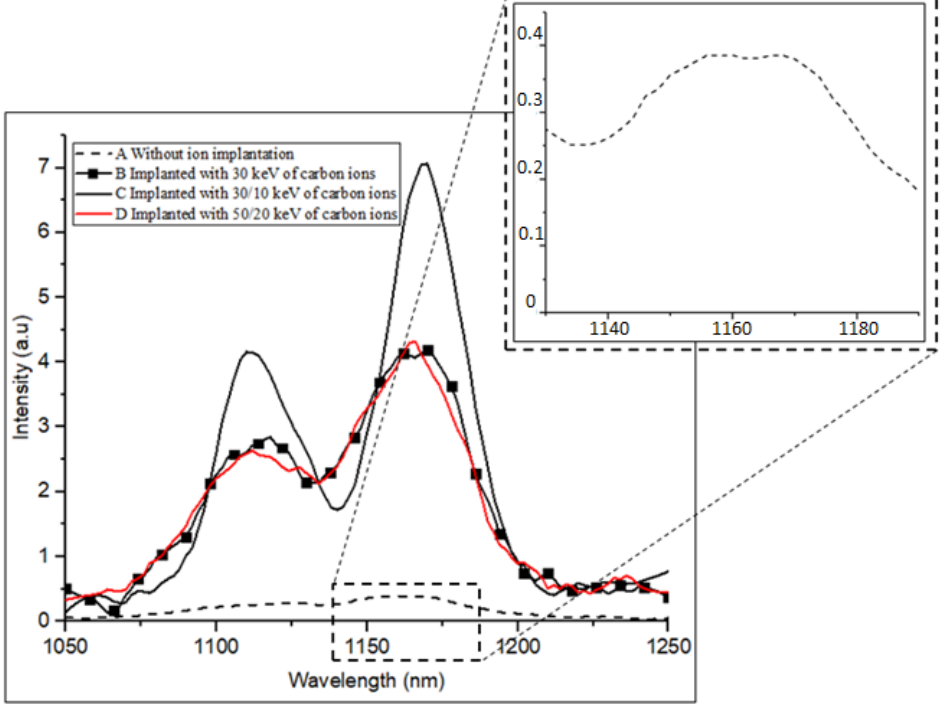
Figure 3. PL spectrum of samples A, B, C and D at 80 K. Sample A is the reference sample without ion implantation. Sample B is implanted with 30 keV of carbon ions, whereas samples C and D have double implantation of 30/10 and 50/20 keV of carbon ions, respectively. FWHM for the highest peak of sample C is 32 nm (29 meV). The inset shows the peak emission in sample A. The laser power was 200 mW.